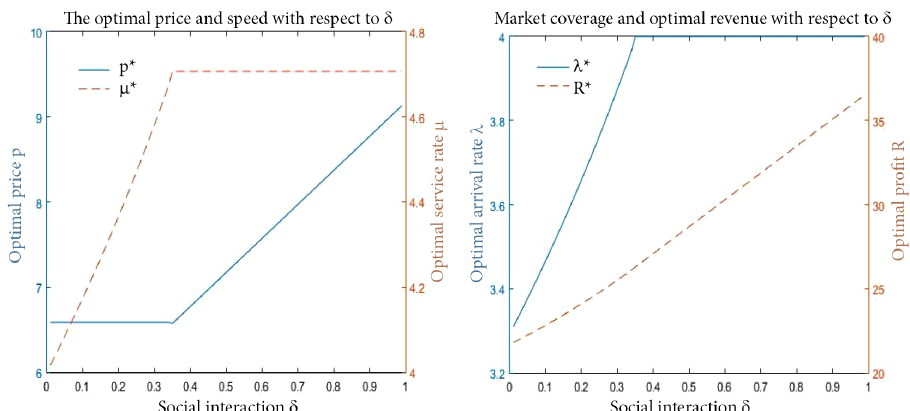
Figure 2. The left panel illustrates the optimal service rate and price with respect to the social interaction intensity d . The right panel illustrates the arrival rate in equilibrium and the optimal revenue with respect to